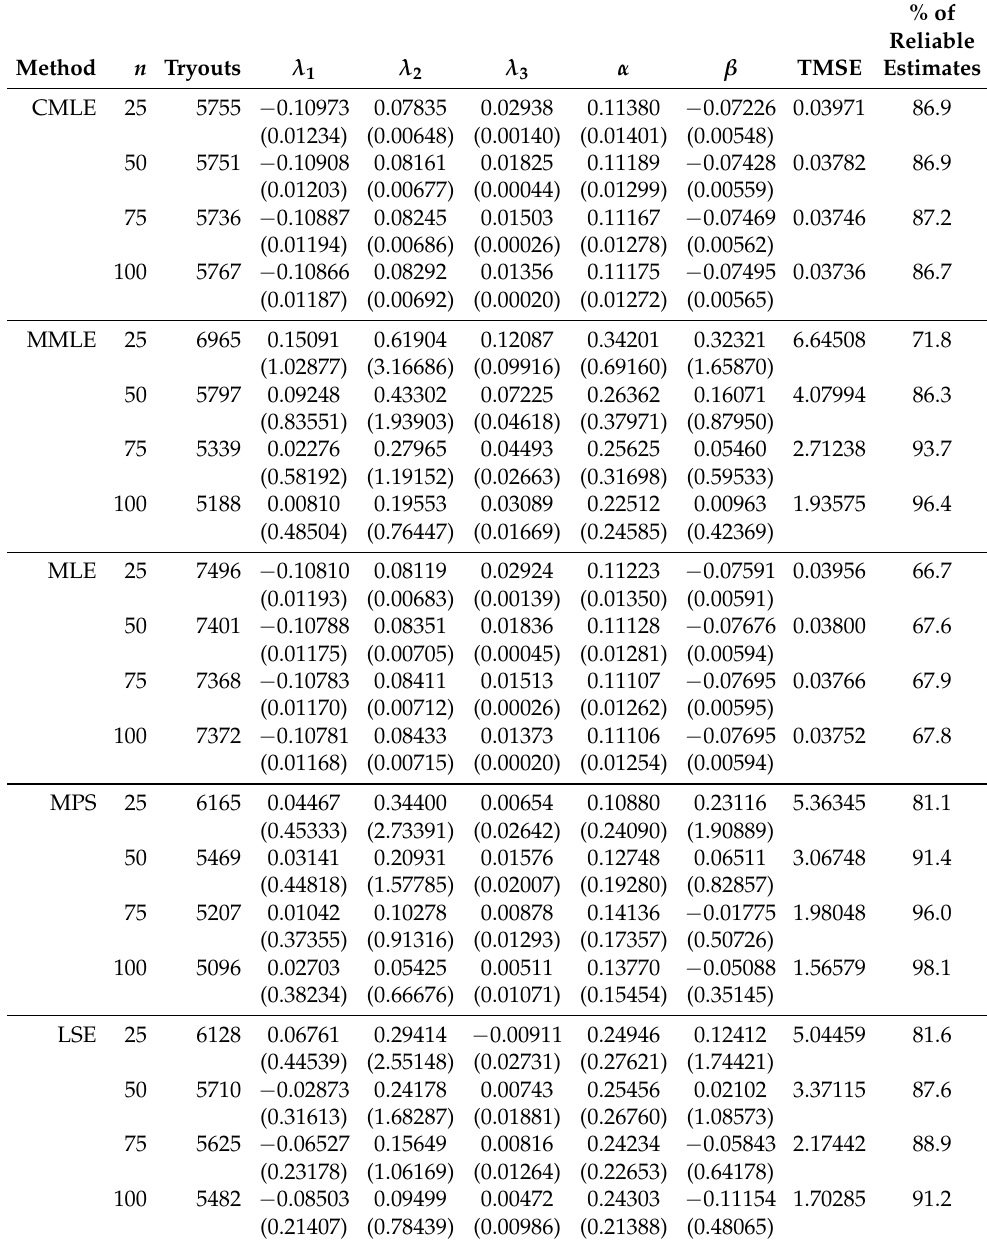
Table 9. Simulated biases and MSEs (in parentheses) of the parameter estimates obtained based